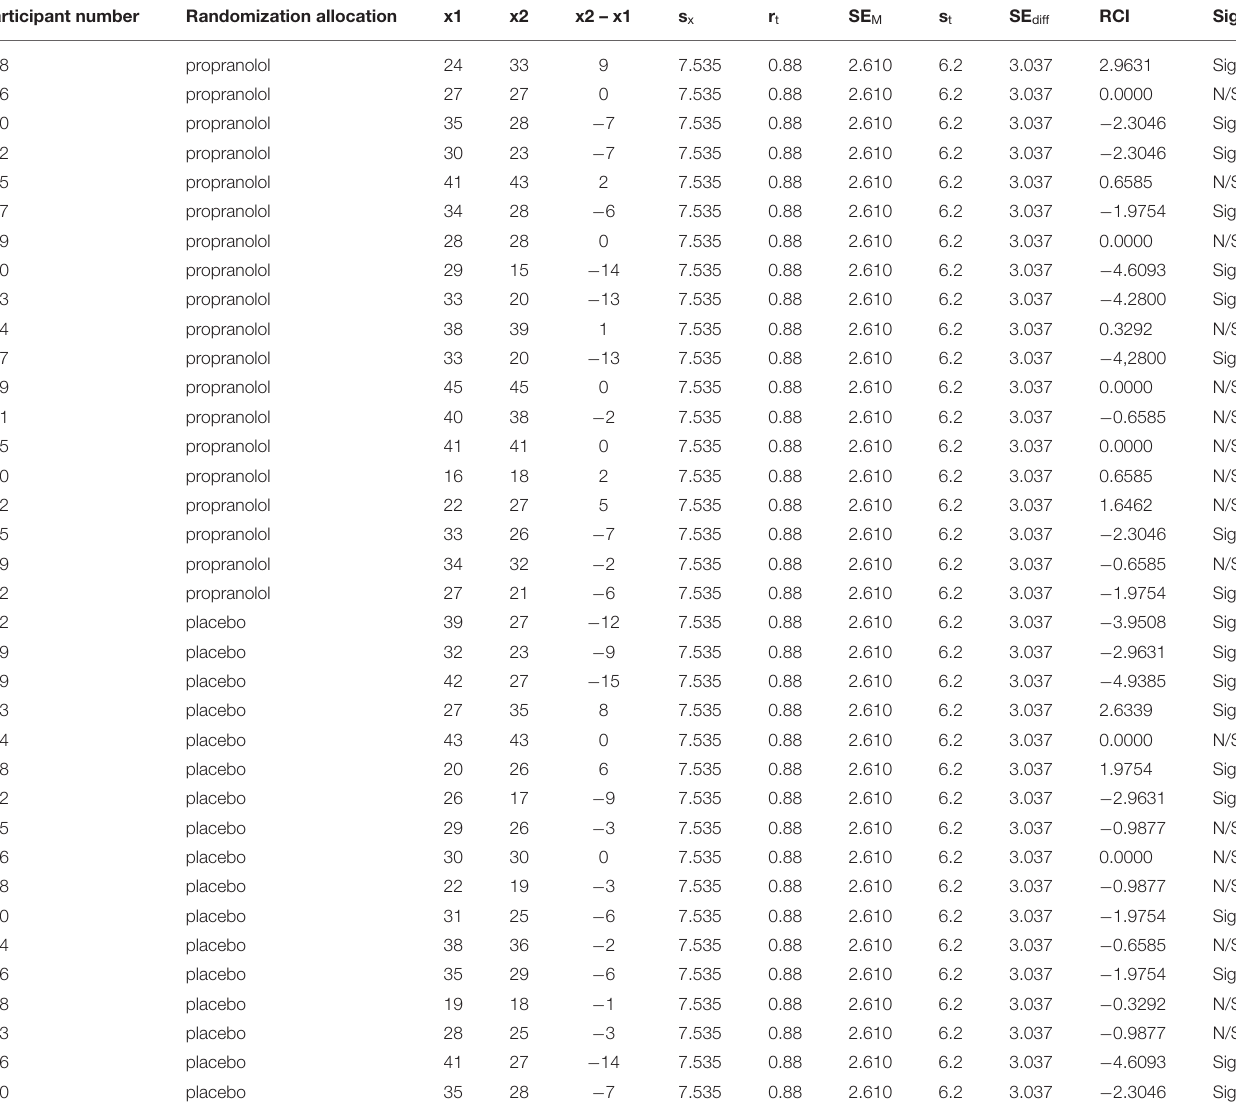
TABLE 3 | Reliable change index for primary outcome measure (S-DAI score). Participant